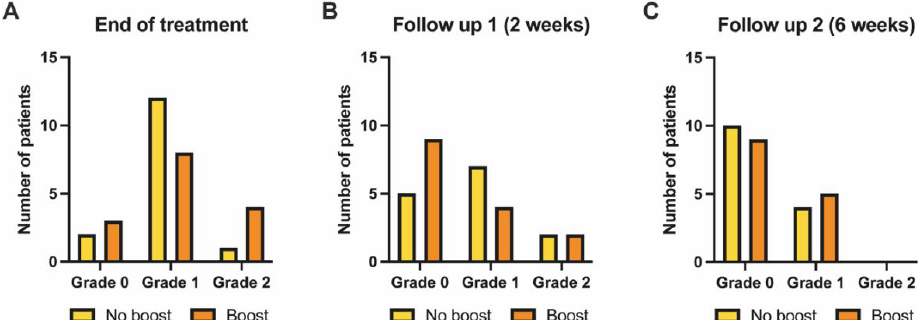
Figure 3. Maximum severity of radiation dermatitis ( A ) upon NIPP and radiation treatment completion and ( B ) at two and ( C ) six weeks follow-up, stratified by absence (yellow) or presence (orange) of a sequential normofractionated boost. Grading according to the National Cancer Institute’s Common Terminology Criteria for Adverse Events (CTCAE) v5.0 [20]. NIPP = non-invasive physical plasma.